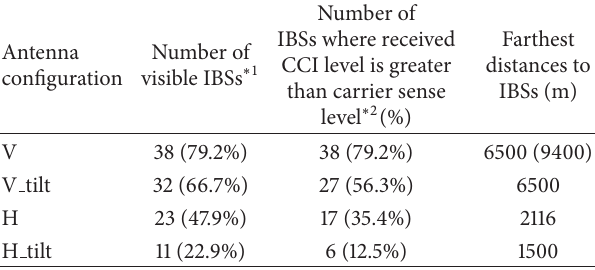
Table 2: Numbers of IBSs and the farthest distances to